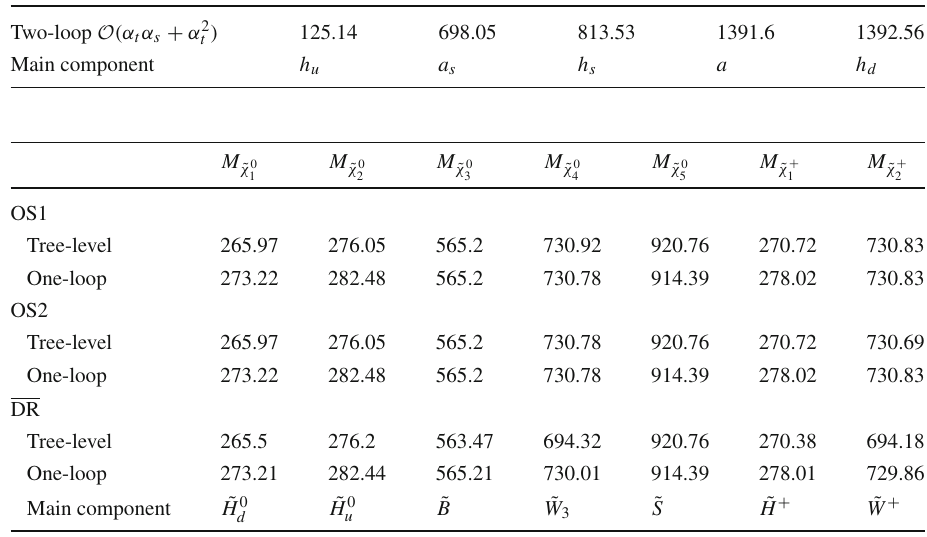
with x denoting any electroweakino, between the loop cor- rected electroweakino masses computed using the Denner and the EMT descriptions presented in Sect. 3.1.2. As can be inferred from the upper plots, the wino-like neutralino ˜ χ 0